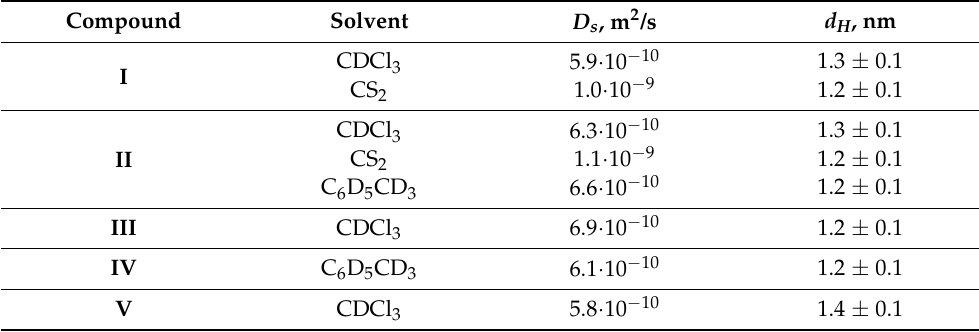
Table 1. The self-diffusion coefficients D s and the diameters d H calculated from Equation (2) for the fullerene derivatives I – V .